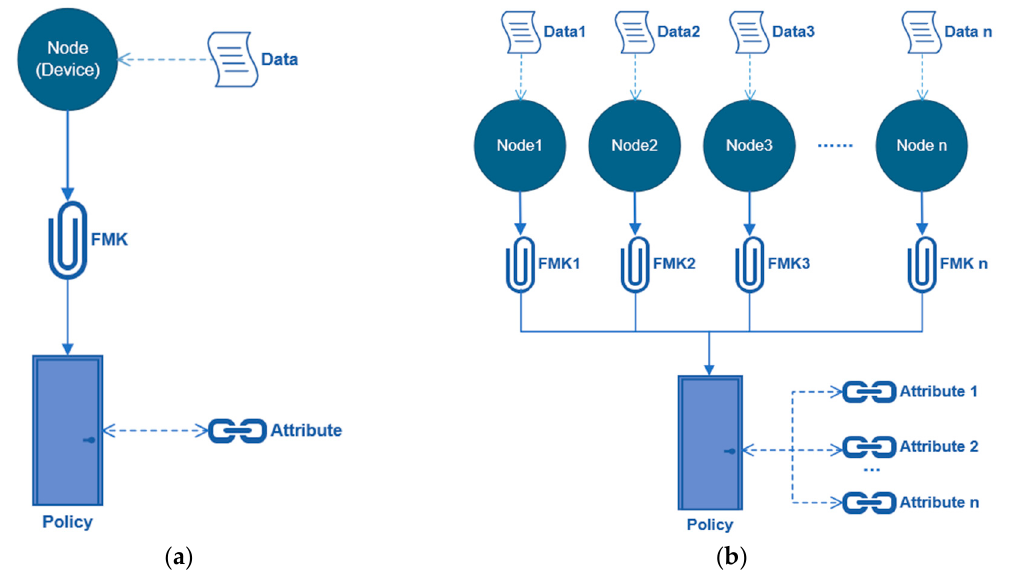
Figure 7. ( a ) The first test based on a single node; and, ( b ) The second test based on multiple nodes.